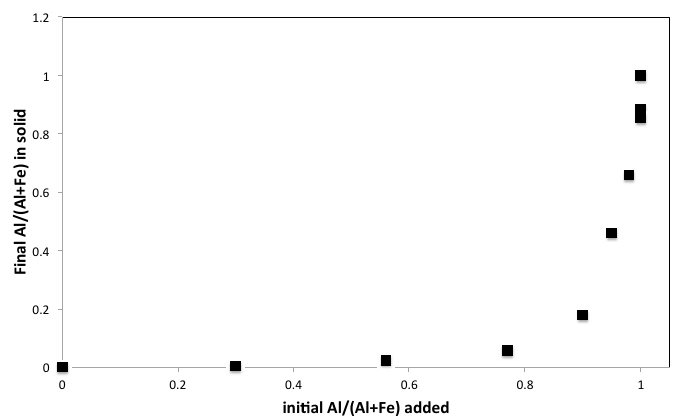
Figure 3. Aluminium ion content in the initial solution versus that found in the solid on collection of the product.